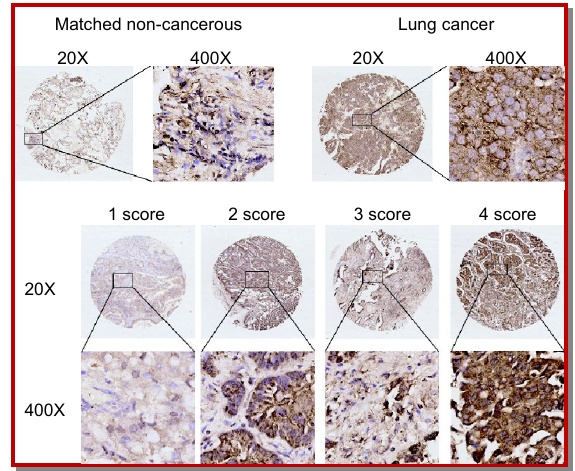
Figure 4: CD26 expression in lung cancer was associated with histological grade. Immunohistochemical staining of CD26 in lung cancer tissues and paired adjacent noncancerous tissues. The staining was scored. Scoring was measured by the per- centage of positive cells with the following staining intensities: less than 5% scored “0”; 5–24% scored “1”; 25–49% scored “2”; 50 –74% scored “3”; and more than 74% scored